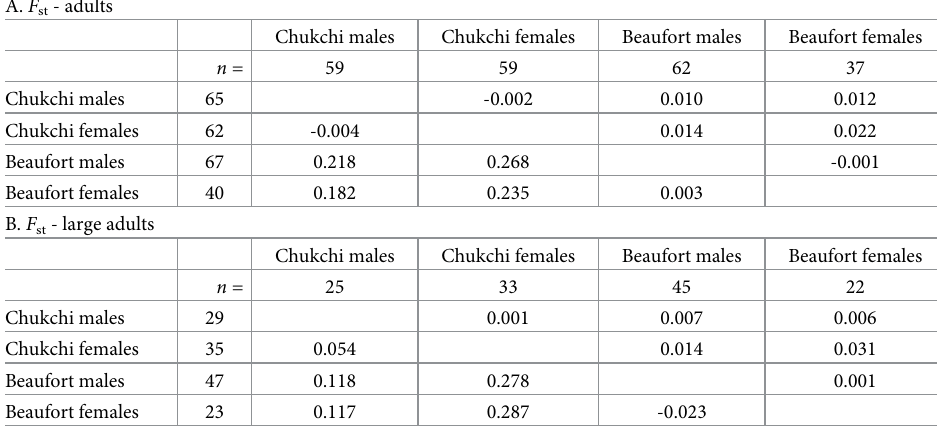
Adult males: (cid:21) 350 cm standard length. Adult females: (cid:21) 300 cm standard